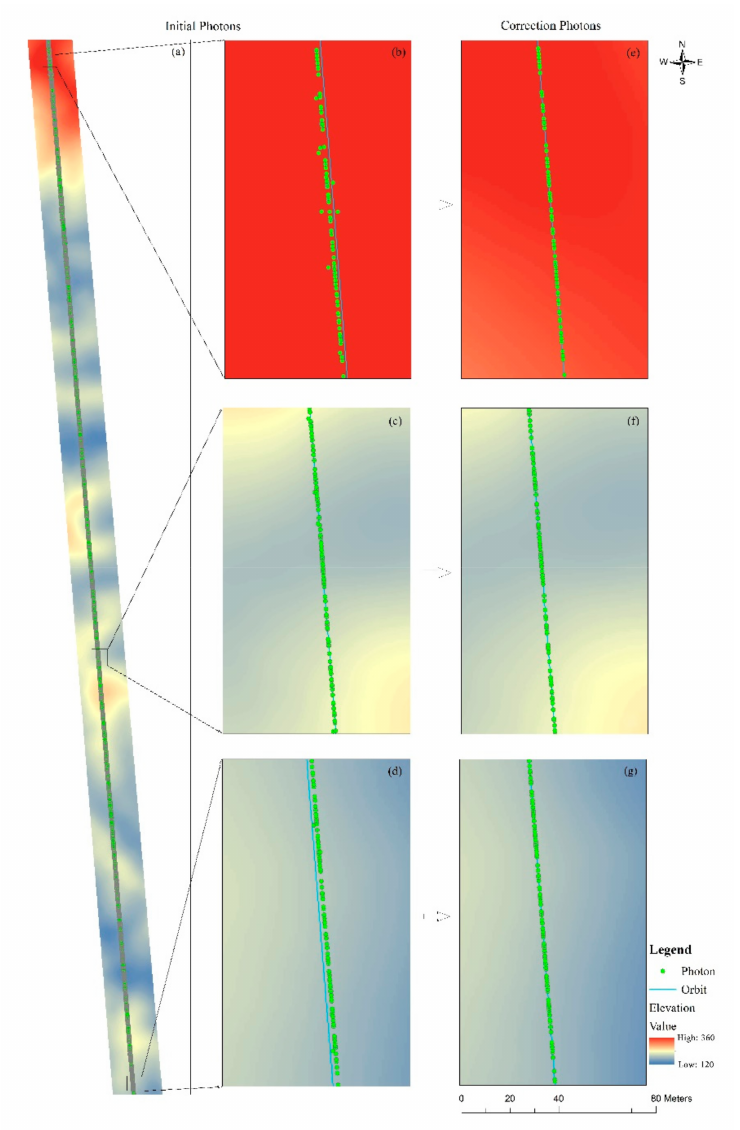
Figure 5. Schematic diagram of the initial photon position and the photon position after correction. ( a – d ) Distribution of photons in the study area. ( e – g ) Positions of the photons after correction of ( b – d ),